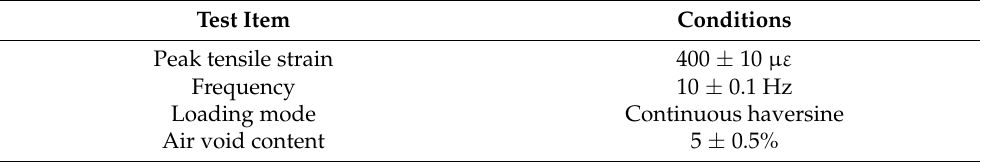
Table 7. Four-point bending testing condition as per AG:PT/T233 [27].